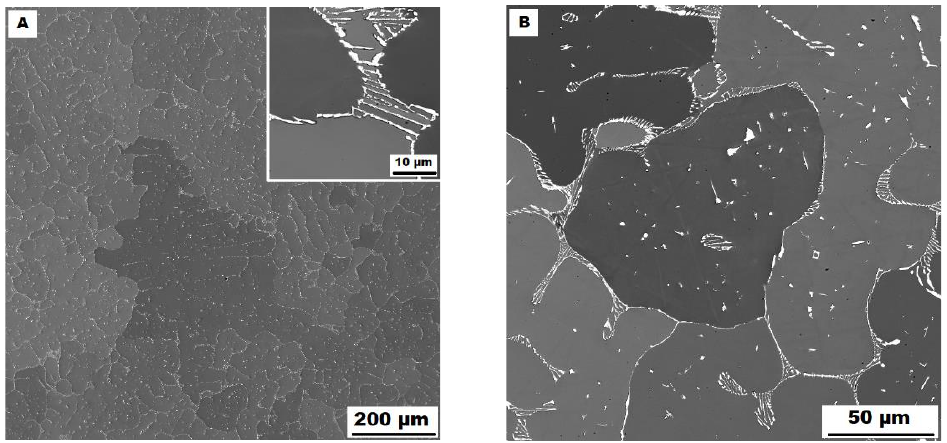
Figure 7. The structure of Fe – 28Al – 5Si – 2Mo – 1B HT 800/100 alloy (SEM, 10 kV, BSE). ( A ) overview of the structure, ( B ) detail of the structure